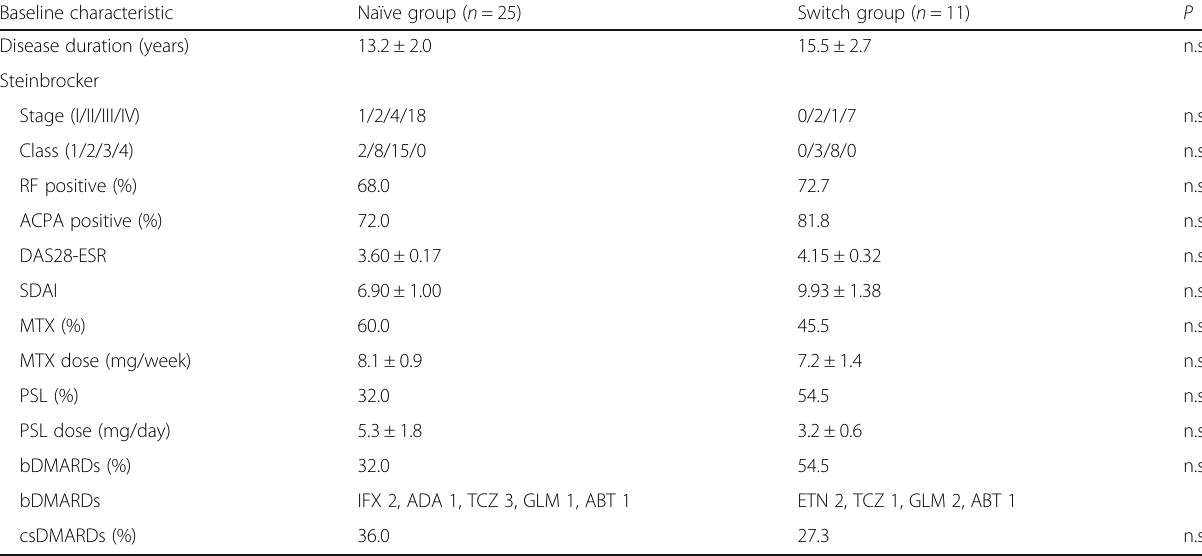
Table 2 Baseline characteristics of RA Baseline characteristic Naïve group ( n = 25) Switch group ( n = 11) Disease duration (years)